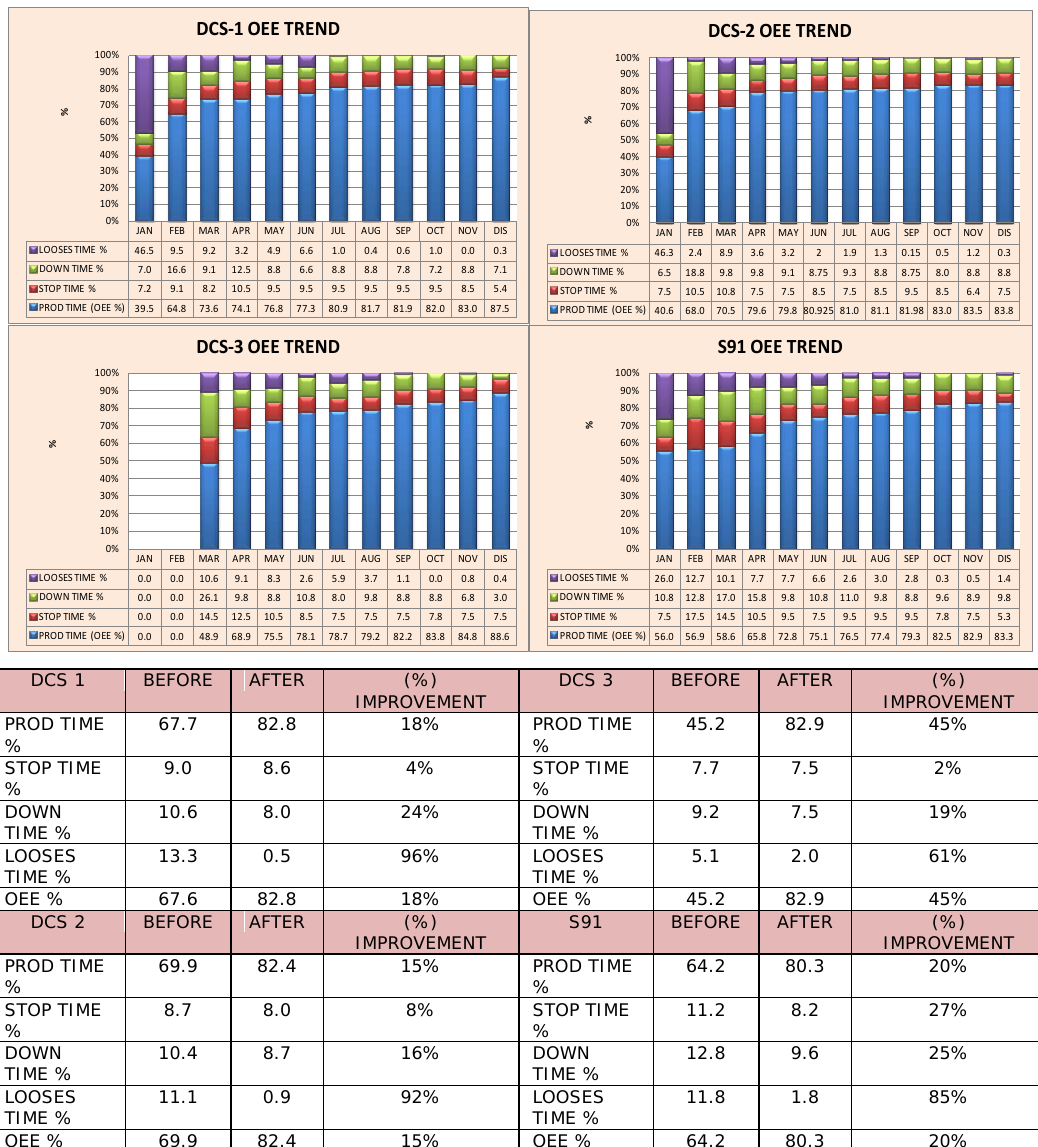
Figure 14. “Percentage of improvement for OEE